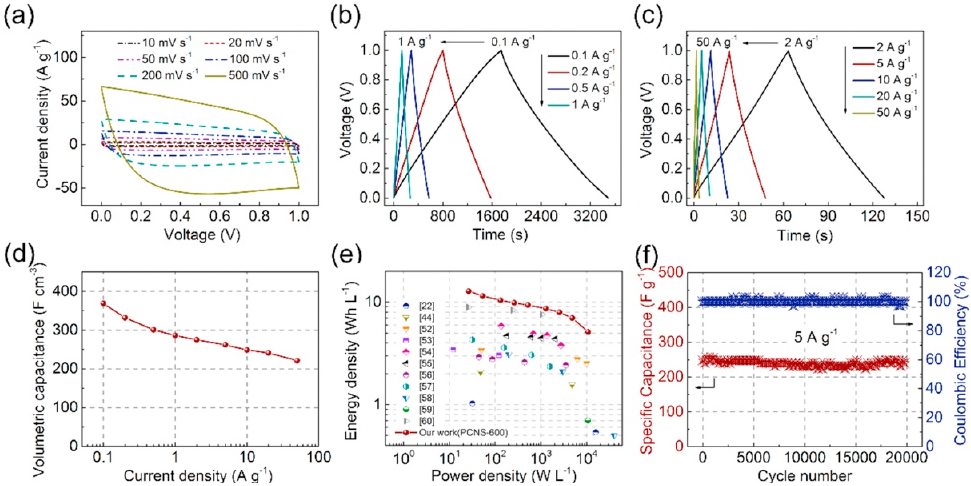
Figure 4 . Electrochemical performance of the PCNS-600//PCNS-600 supercapacitor in 6M KOH aqueous electrolyte. ( a ) Cyclic voltammetry curves at the scan rates from 10 to 500 mV/s. ( b,c ) Galvanostatic charge-discharge curve at various current densities from 0.1 A/g to 50 A/g. ( d ) Volumetric capacitance at the current densities from 0.1 A/g to 50 A/g. ( e ) Ragone plot and performance comparison with the state-of-the-art reported works. ( f ) Cycling stability after 20,000 cycles at 5 A/g. Reprinted from [133]. Copyright (2018), with permission from Elsevier.